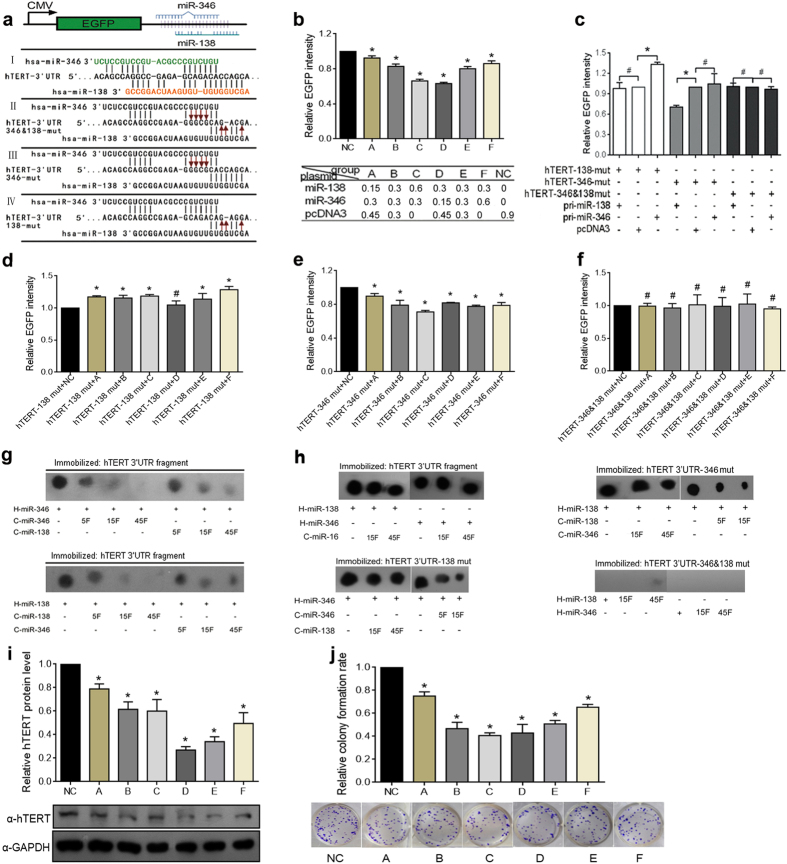
miR-346 and miR-138 competitively regulate hTERT expression and function.(a) (I) The predicted miR-346 and miR-138 binding sites on the hTERT mRNA 3′UTR, (II) a double mutant of both the miR-346 and miR-138 binding sites, and (III) miR-346 or (IV) miR-138 single mutant binding sites. (b) EGFP reporter assays were performed to evaluate the effects of various concentrations of miR-346 to miR-138 ratios on wild type hTERT 3′UTRs. The EFGP intensity was normalized to RFP. The present doses of plasmids are for 24-well plastic cell culture plate. (c) EGFP reporter assays were used to evaluate the effects of miR-346 and miR-138 on the three types of mutant hTERT 3′UTR. The relative EGFP/RFP intensity in treated group was normalized to the control group. (d–f) EGFP reporter assays were adopted to analyze the influence of varied ratios of miR-346 to miR-138 on EGFP reporters with the three mutant forms of the hTERT 3′UTR. The EFGP intensity was normalized to control group. (g,h) Dot blot hybridization assays show dose-dependent competition between miR-346 and miR-138 for binding to the wild type hTERT 3′UTR fragment and three types of mutant hTERT 3′UTRs. miR-16 is a non-competing miRNA and serves as a negative control. H and C represent hot (labeled) and cold (non-labeled) miRNAs. The blots represented the full-length blots. (i) The relative hTERT protein levels in HeLa cells transfected with different ratios of miR-346 to miR-138 were evaluated by western blot. GAPDH was used as a loading control. The gels were cropped and the full-length gels are presented in Supplementary Fig. S8. (j) The colony formation rate increased with an increasing miR-346 to miR-138 ratio. The experiments were performed in triplicate. *p < 0.05, #p > 0.05.